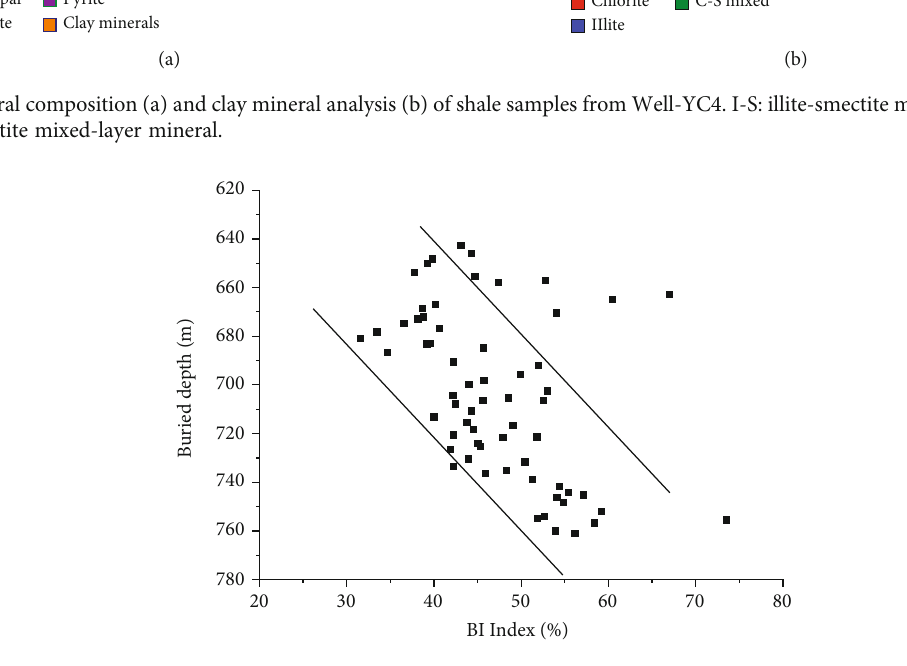
Figure 4: Vertical variation of BI value for the WL shale in